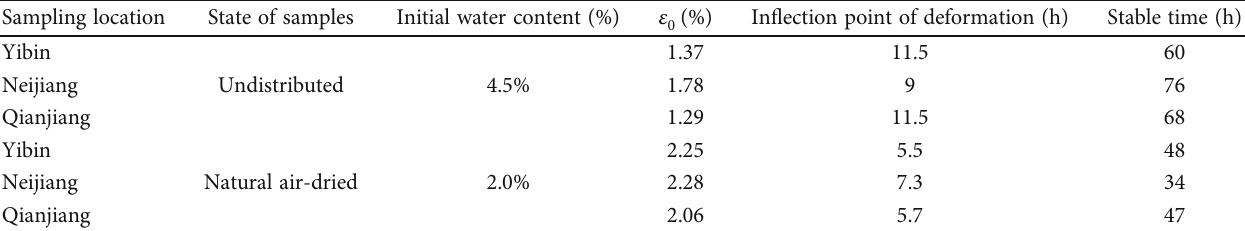
Table 3: Water immersion test results of undisturbed red-bed soft rock.